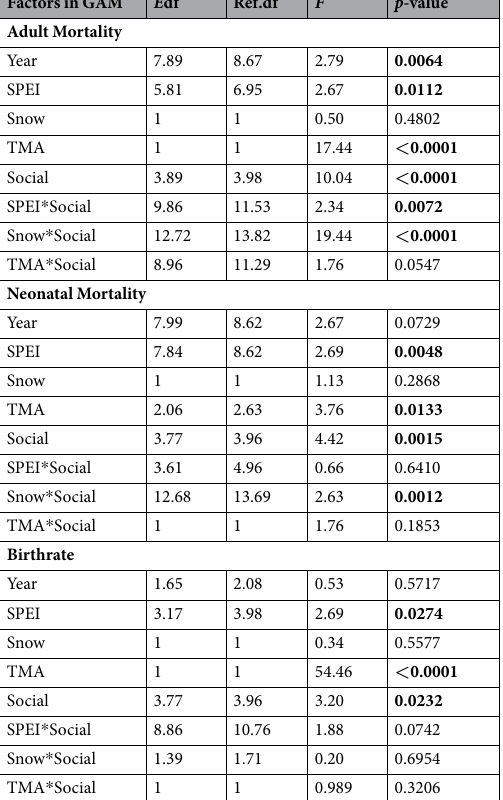
Table 3. GAM Results for Climate and Sociopolitical Factors in Full Models. Note: full models were optimal models for each demographic metric. SPEI, Snow, and TMA corresponded to winter harshness, drought, and growing season harshness. Bald values indicate significance ( <